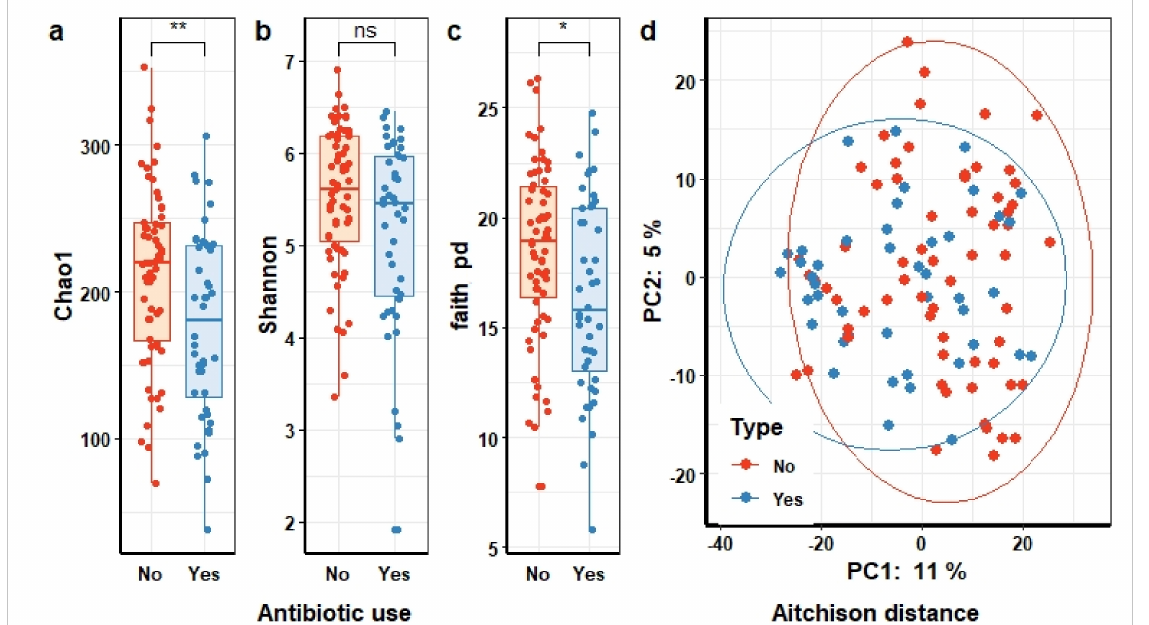
Figure 3. Differences in gut microbial community structures and taxonomic composition in association to antibiotic use in the 4 months prior to feces sampling. Differences in microbial richness (Chao1) ( a ) and diversity (Shannon ( b ) and Faith’s pd ( c )) between people who did or did not use antibiotics. Statistical significance (FDR q -value < 5 × 10 − 2 ) determined by Wilcoxon test. ( d ) Principal component analysis based on Aitchison distance colored according to antibiotic use (PERMANOVA test, FDR q -value < 5 × 10 − 2 ). Each point represents the gut microbial community structure of an individual that did (blue) or did not (red) use antibiotics. Symbols show the statistical significance levels, ns indicates p > 5 × 10 − 2 , * indicates p < 5 × 10 − 2 , ** indicates p < 1 × 10 − 2